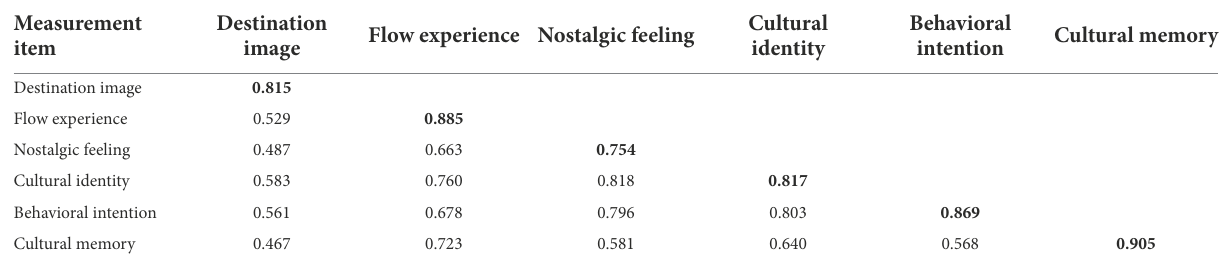
TABLE 2 Discriminant validity test.